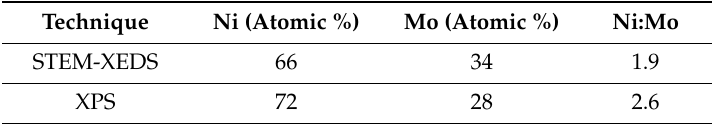
Figure 1. SEM image of the nanoparticles with the graph showing the size distribution. ( a ) The SEM image, showing nanoparticles evenly dispersed on the SiO x substrate; ( b ) The size distribution of the particles selected by the DMA. Singly charged particles that pass through the DMA have a diameter of 25 nm, while a small fraction of doubly charged particles has a diameter of 35 nm. Table 1. Average atomic percentage of Ni and Mo calculated from the STEM-XEDS spectra and the XPS spectra from the particles Technique Ni (Atomic %) Mo (Atomic %) Ni:Mo STEM-XEDS 66 34 1.9 XPS 72 28 2.6